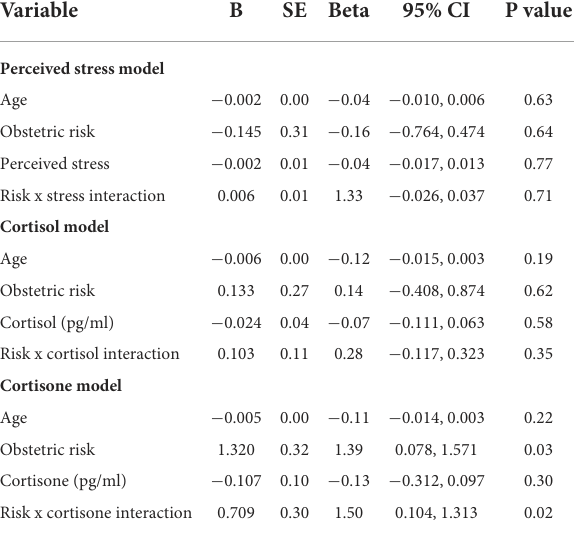
TABLE 3 Linear regression models for effects of maternal perceived stress, cortisol, cortisone, and the moderating effect of obstetric risk on gestational length.